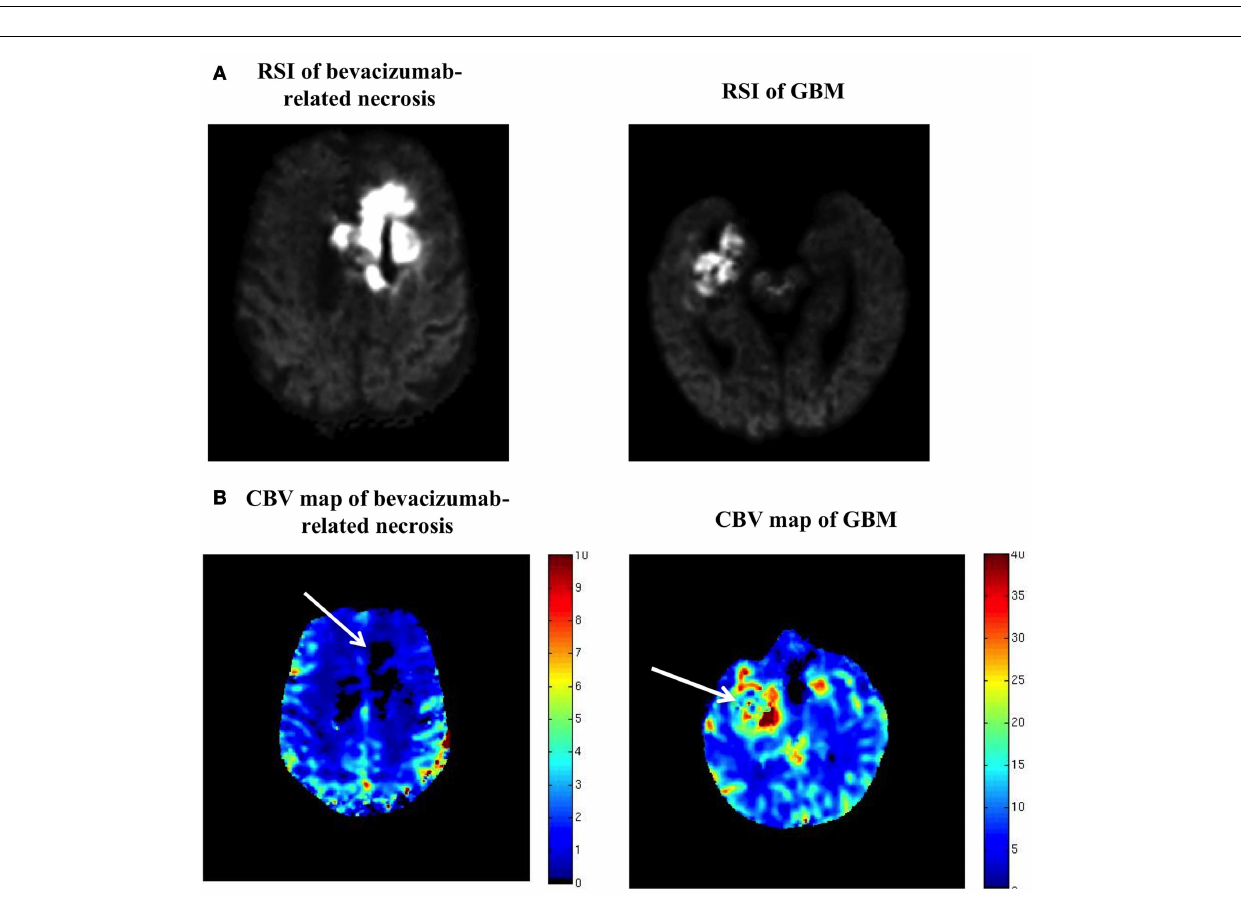
identically (i.e., same window and level). (B) is a side-by-side comparison of the DSC MR perfusion-generated CBV map for this patient and the CBV map for the same patient with GBM shown in (A) (with adjacent color